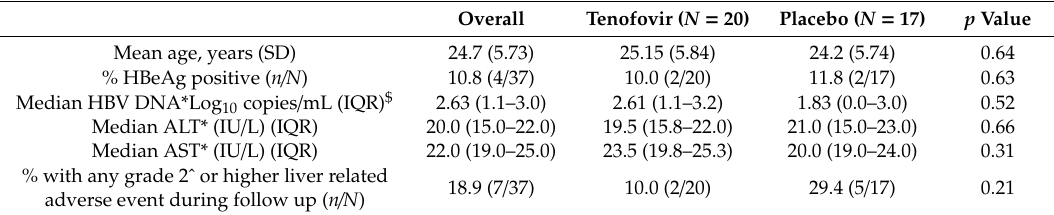
Clinical and virological characteristics of the 37 women infected with HBV by treatment